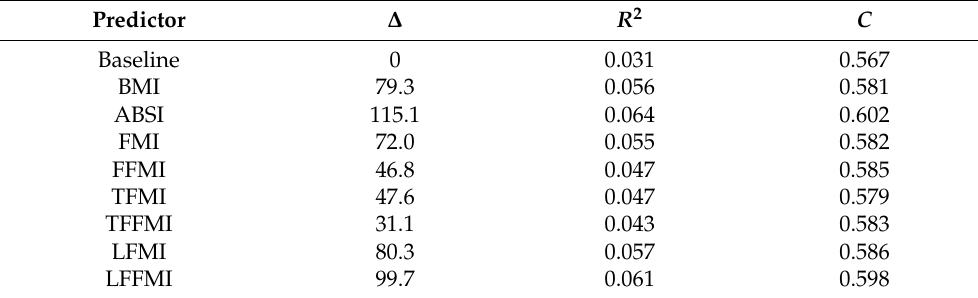
Table 3. The association of each body measure with mortality